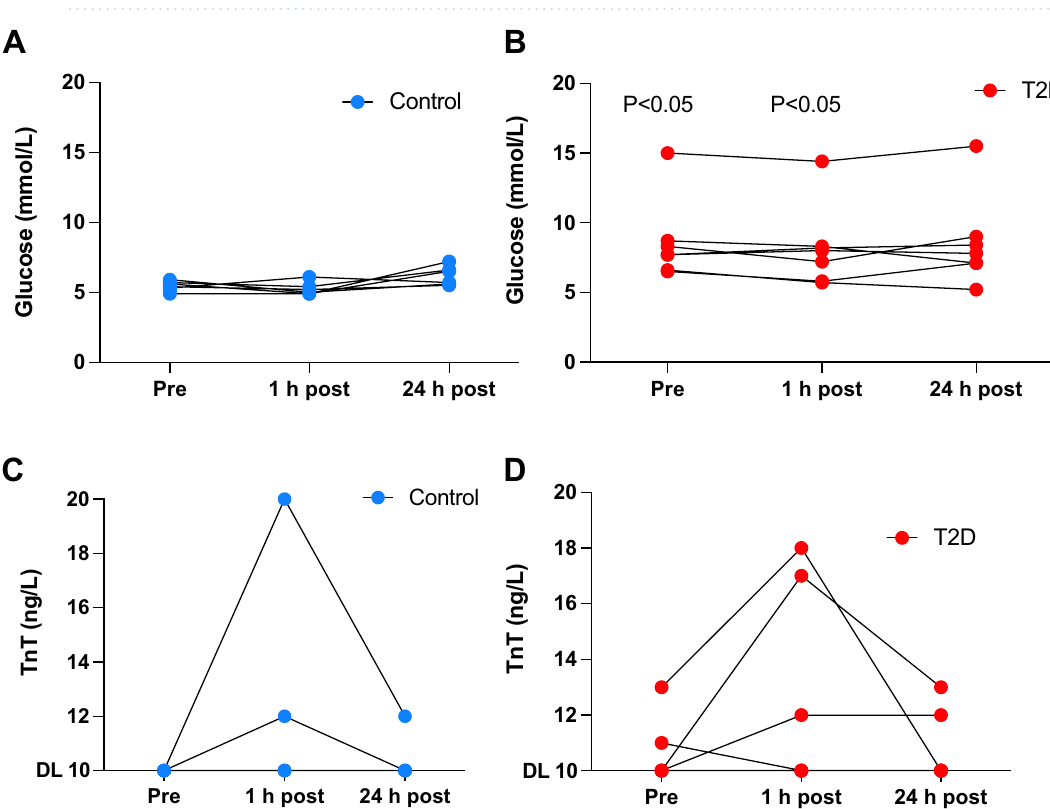
Figure 2. Blood sample data from baseline (Pre) and 1 h and 24 h post-exercise. ( A ) Glucose in the control group; ( B ) glucose in the T2D group; ( C ) Troponin T (TnT) in the control group; ( D ) TnT in the T2D group. Presented with individual data at each time-point. The detection limit for TnT was 10 ng/L. p values between T2D and control are indicated. Control: n = 7, T2D: n = serum TnT levels that remained elevated after 24 h. Two participants in the control group had elevated TnT levels exceeding 10 ng/L post-exercise; the participant with the highest measured TnT level (20 ng/L) remained above 10 ng/L 24 h post-exercise (Fig. 2C,D).